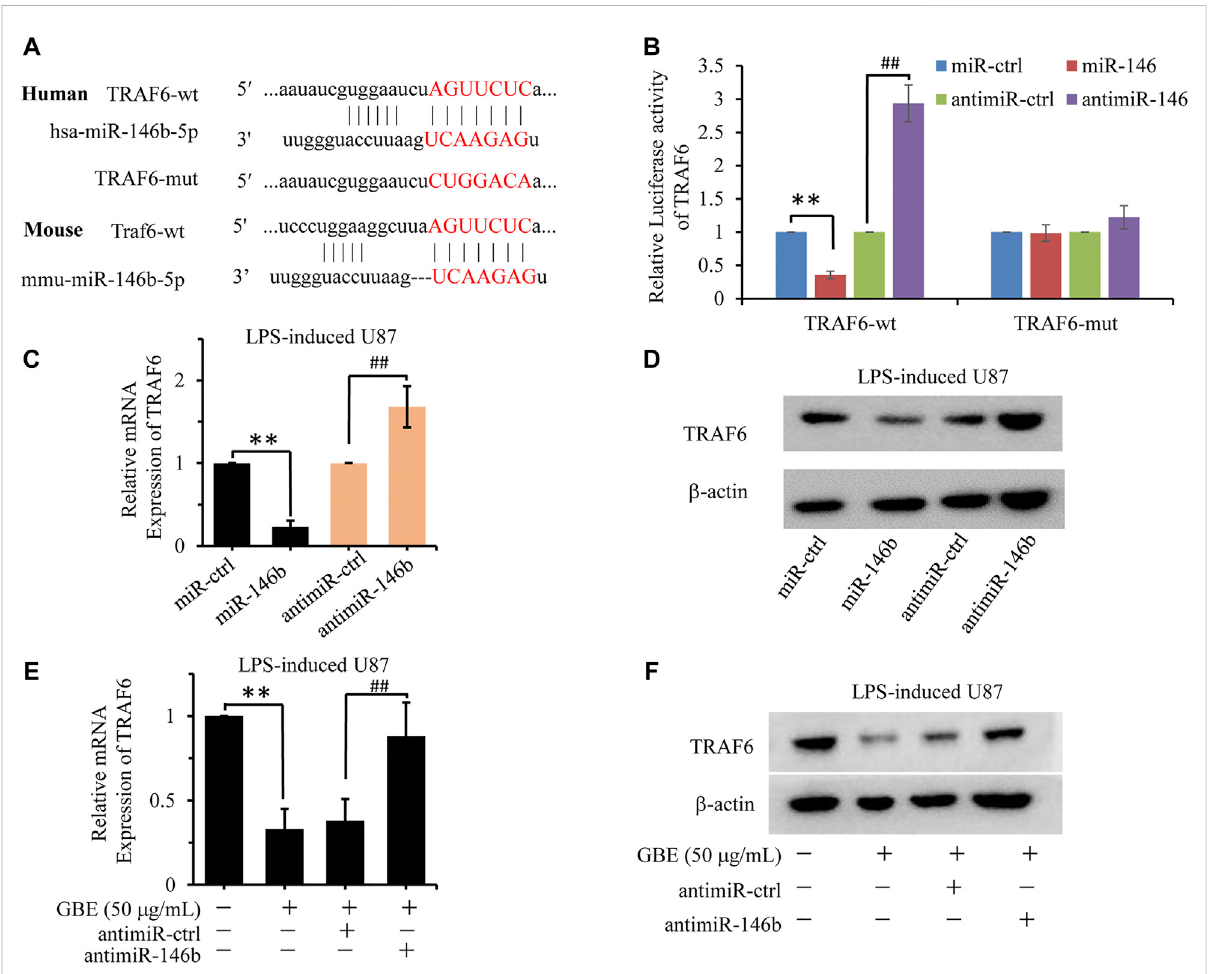
FIGURE 8 GBEdownregulatedTRAF6-mediatedin fl ammationresponse via miR-146b-5p. (A) Theputativetargetsitesofhsa-miR-146b-5pormmu-miR- 146b-5p in TRAF6 were predicted by TargetScanHuman. The mutant binding sequence in TRAF6 with miR-146b-5p is also shown. (B) Luciferase assay of 293T cells co-transfected with fi re fl y luciferase constructs containing the TRAF6 wild-type or mutated 3 ′ -UTRs and miR-146b-5p mimic, negativecontrol(NC)mimic,miR-146b-5pinhibitor,orinhibitorNC.** p < 0.01vs.mimicNC,## p < 0.01vs.inhibitorNC. (C,D) Theexpression of TRAF6 was detected at both mRNA (C) and protein levels (D) in LPS-induced U87 cells with miR-146b-5p mimic, NC mimic, miR-146b-5p inhibitor, or inhibitor NC treatment. ** p < 0.01 vs. NC mimic, ## p < 0.01 vs. inhibitor NC. (E,F) The expressionof TRAF6 was detected atboth mRNA (E) and proteinlevels (F) in LPS-induced U87 cells with GBE (0 and 50 µg/ml), miR-146b-5pinhibitoror inhibitorNC treatment. ** p < 0.01 vs. vehicle control, ## p < 0.01 vs. inhibitor